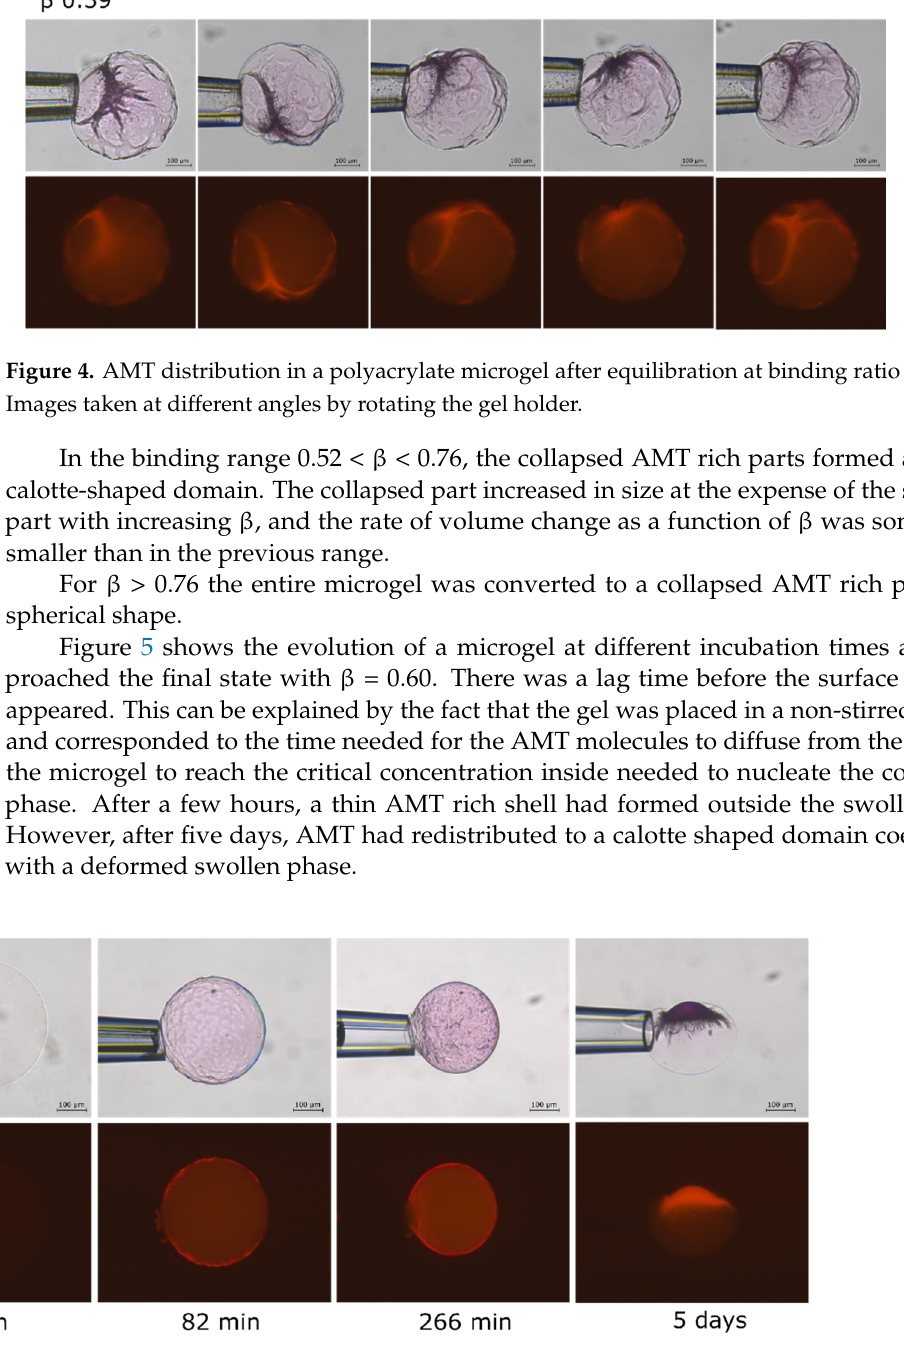
Figure 5. AMT distribution in a polyacrylate microgel at β = 0.60. Images of the microgel taken at different times to show the redistribution of the AMT inside the gel.